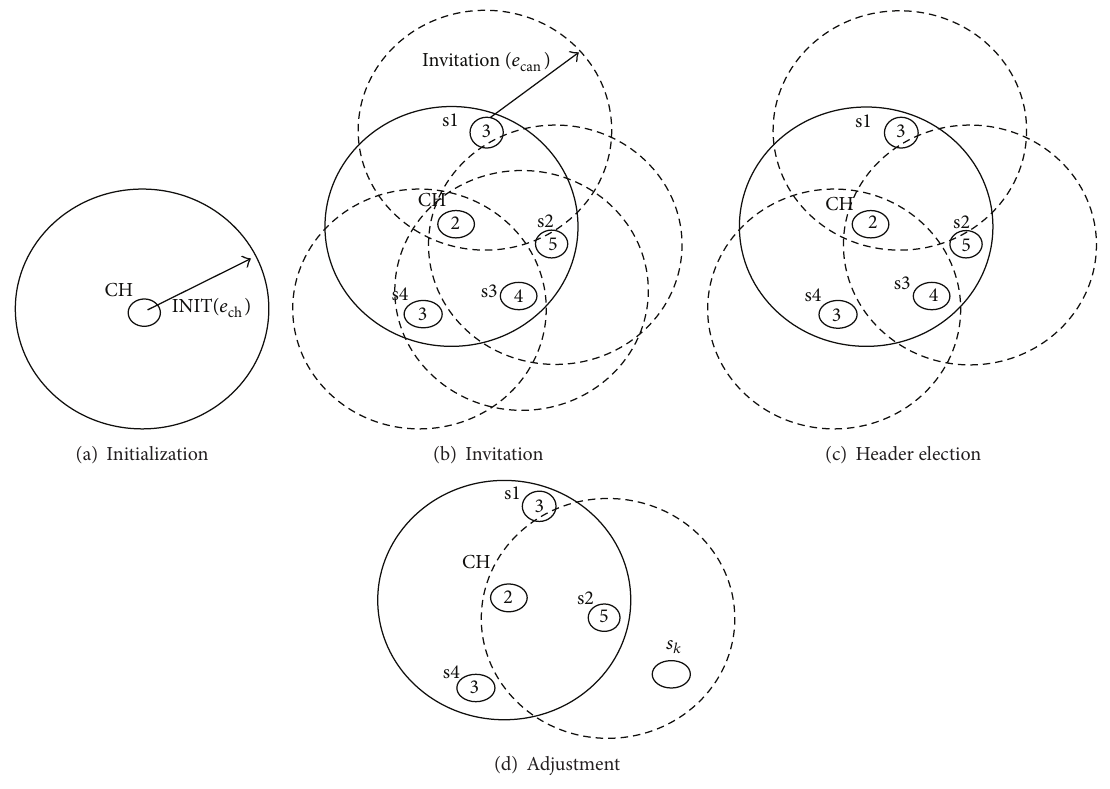
Figure 4: Cluster management